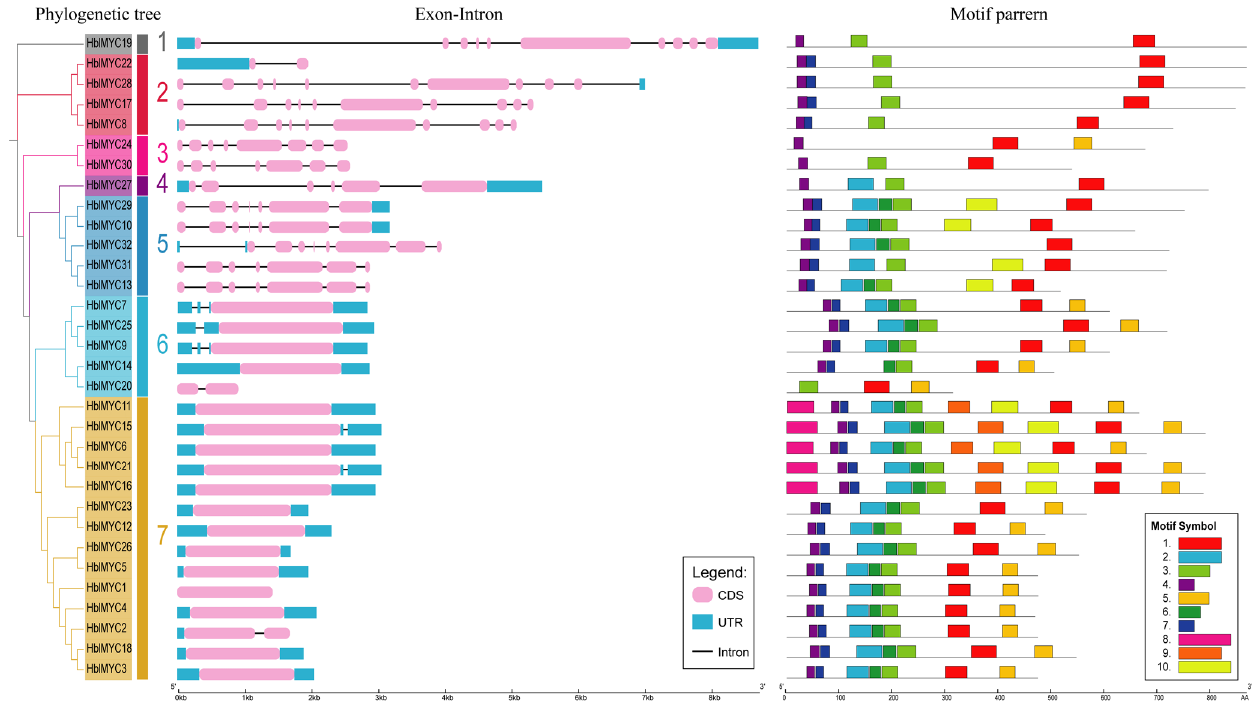
Figure 2. Phylogenetic tree, gene structure and conserved motif of the HblMYCs . Different colors on the phylogenetic tree represented different groups of the HblMYC gene family. In exon-intron analysis, the black lines represented introns, the pink boxes represented the coding sequences, and the blue boxes represented the non-coding sequences. In the motif pattern, the motif number 1–10 were displayed in different colored boxes.